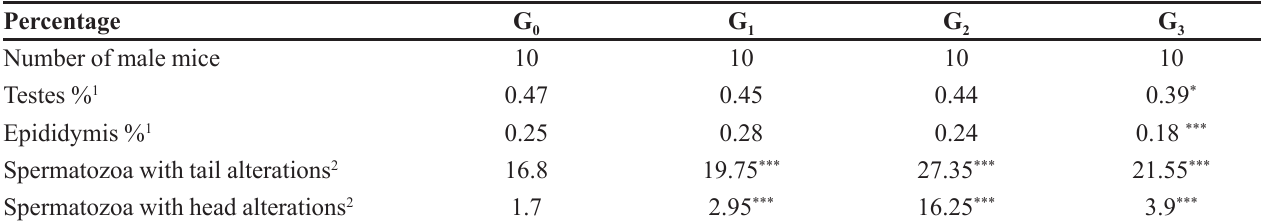
TABLE III - Male mice testes, epididymis, and spermatozoa morphological evaluation Percentage